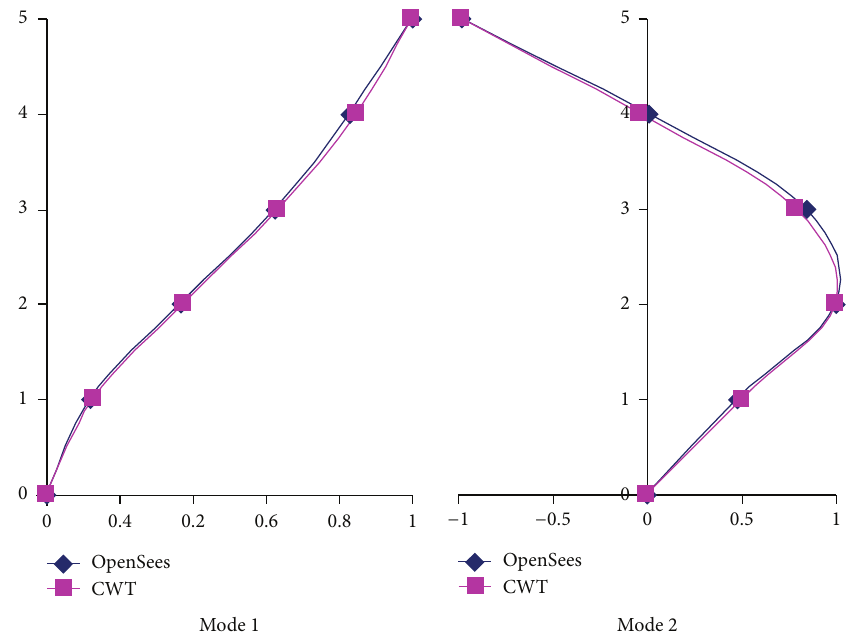
Figure 9: Comparison of the mode shapes obtained using numerical model and the